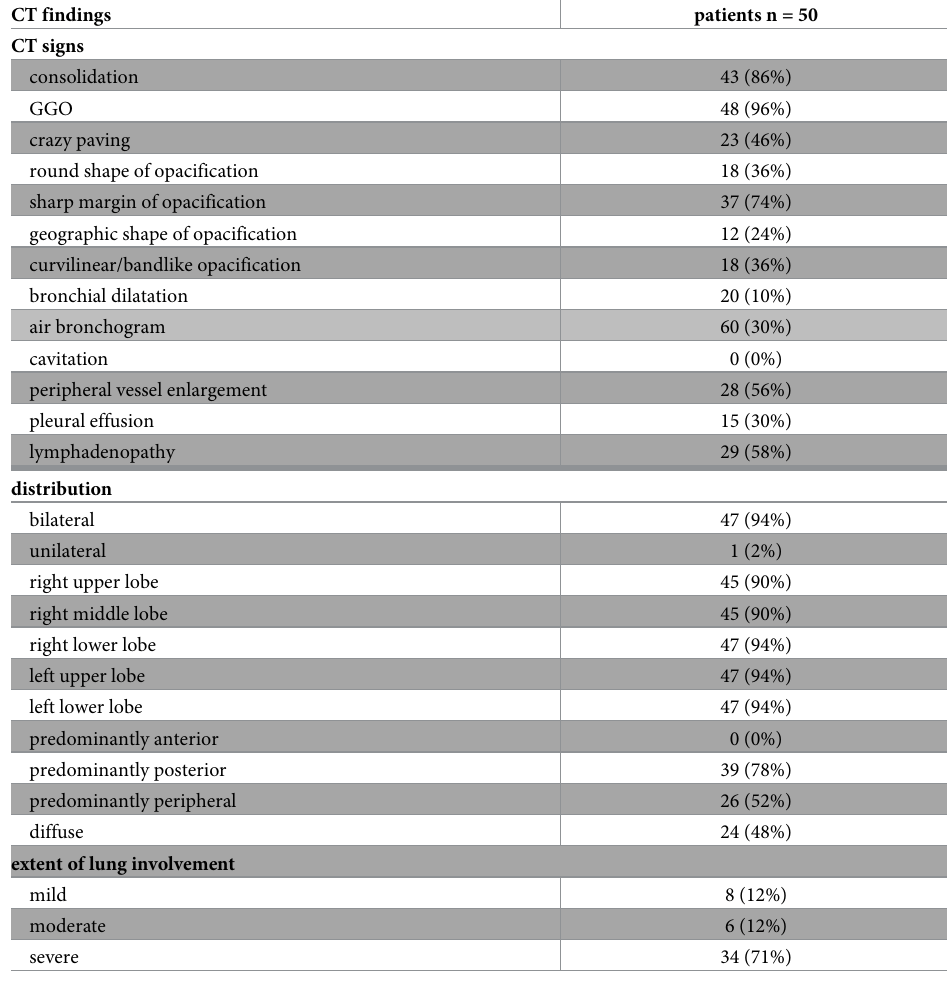
Table 2. CT characterization of pulmonary